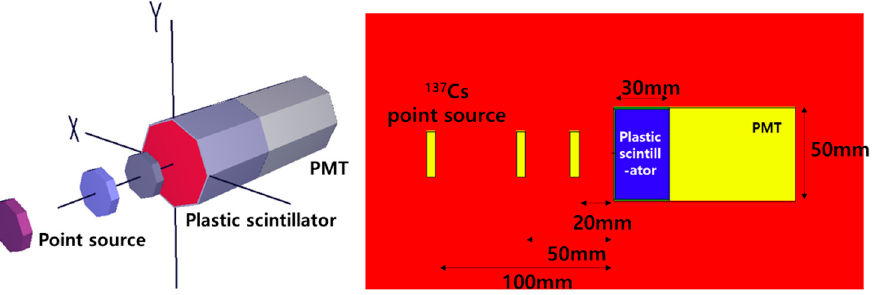
Figure 4. Geometry for computational simulation of 30-mm-thick plastic scintillators.